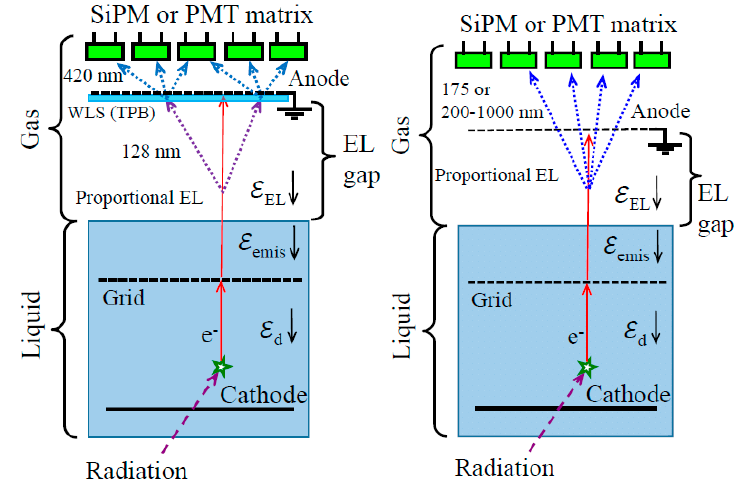
Figure 1. Basic concepts of light signal amplification in two-phase detectors, using proportional electroluminescence (EL) in the EL gap. Left: with indirect optical readout via wavelength shifter (WLS), in two-phase Ar using excimer emission in the vacuum ultraviolet (VUV) at 128 nm. Right: with direct optical readout, either in two-phase Xe using excimer emission in the VUV at 175 nm, or in two-phase Ar using neutral bremsstrahlung (NBrS) emission in the non-VUV range (at 200–1000 nm).